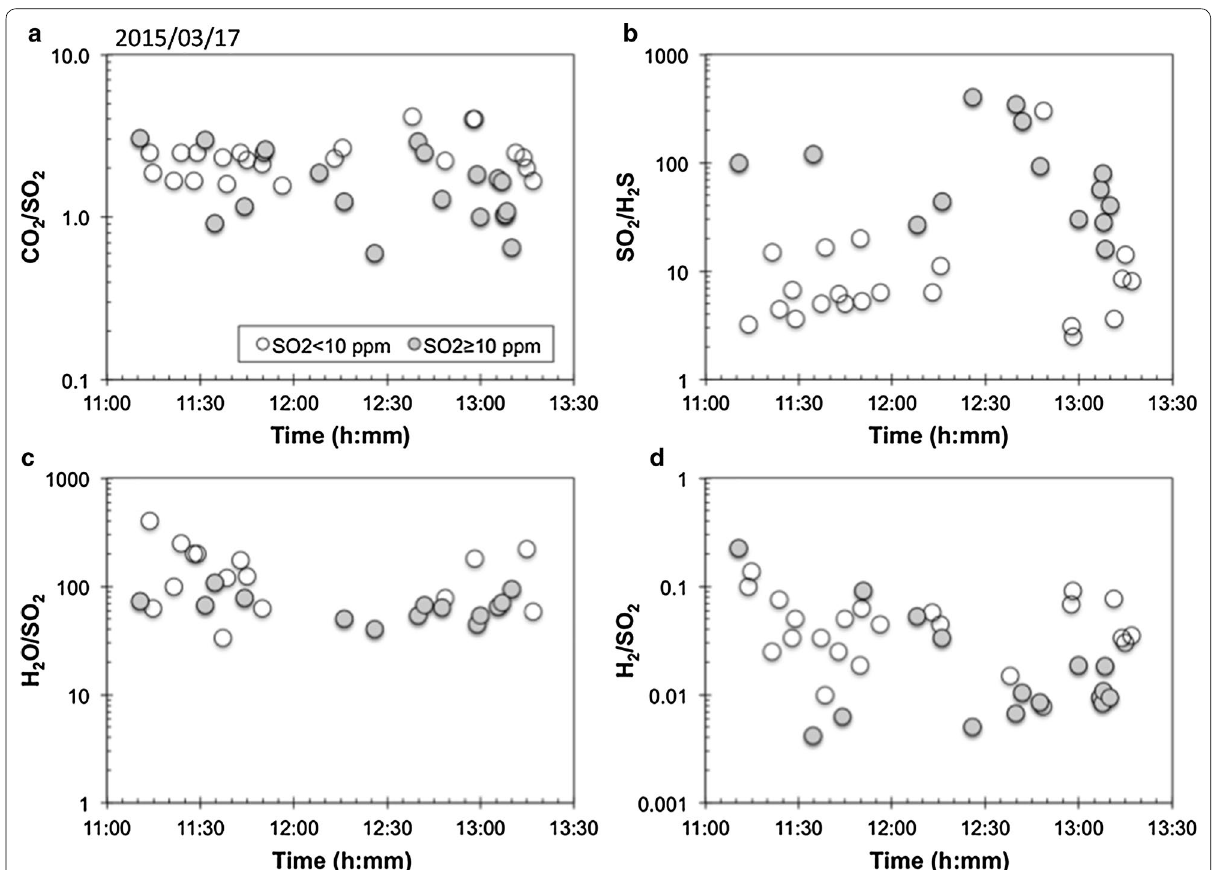
Fig. 6 A short-term variation of gas concentration molar ratios on 17 March 2015. a CO 2 /SO 2 molar ratio, b H 2 O/SO 2 molar ratio, c SO 2 /H 2 S molar ratio, and d H 2 /SO 2 molar ratio. Grey circles show ratios obtained for high concentration peaks of SO 2 concentration peaks of SO 2 <